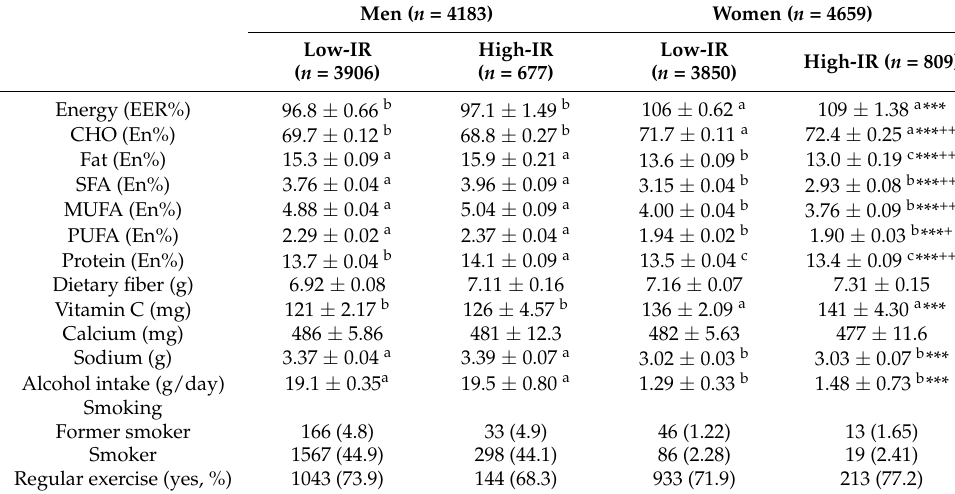
Table 2. Nutrient intake and lifestyle-related